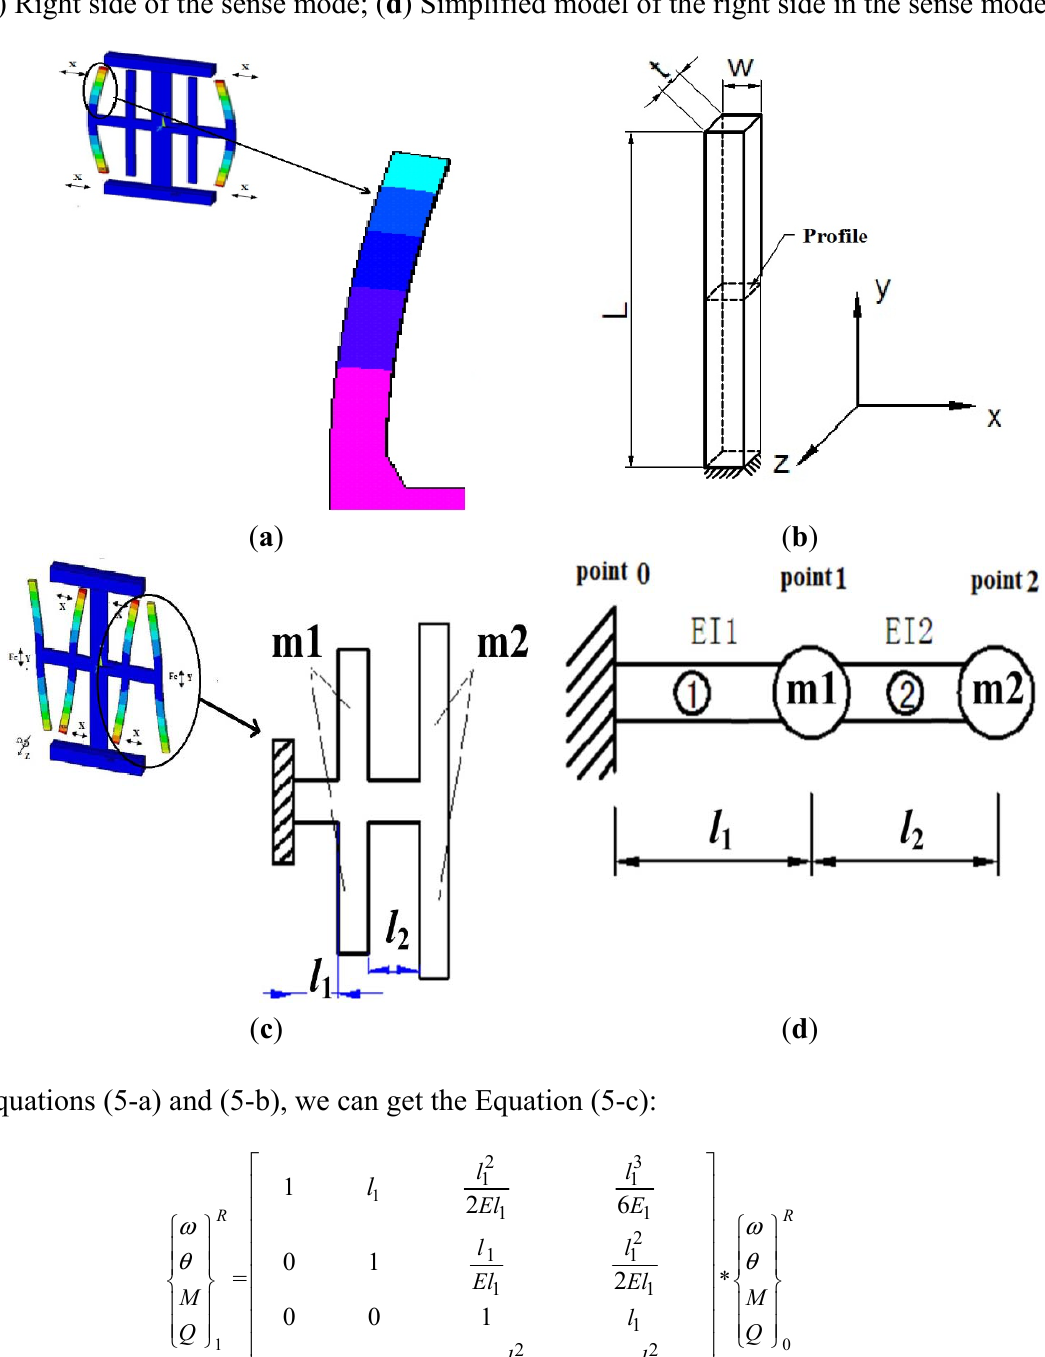
Figure 4. ( a ) One beam of the drive mode; ( b ) Simplified model of the drive fork; ( c ) Right side of the sense mode; ( d ) Simplified model of the right side in the sense